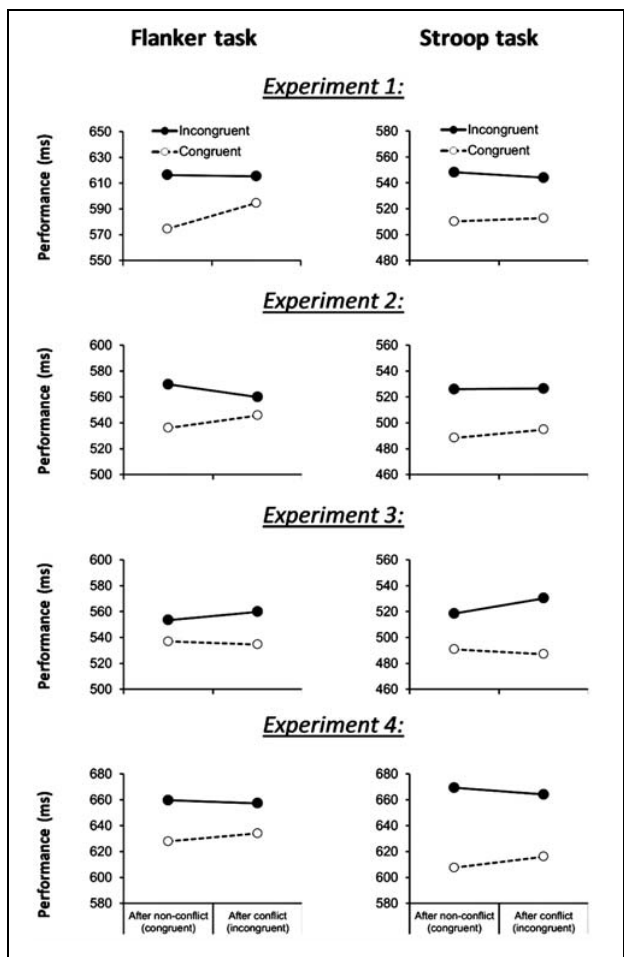
FIGURE 1 | Flanker task (left column) and Stroop task (right column) performance across Experiment 1, 2, 3, and 4, as a function of current-trial congruency and previous-trial